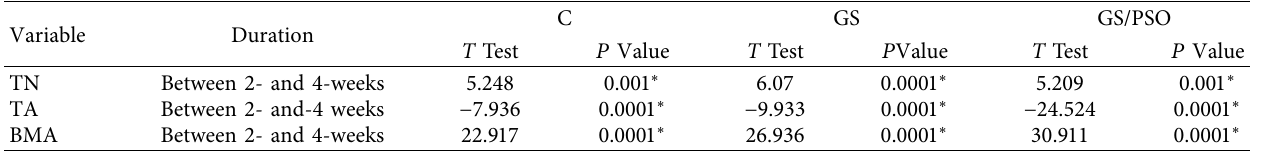
Table 2: Duration comparison of TN, TA, and BMA in all studied groups.